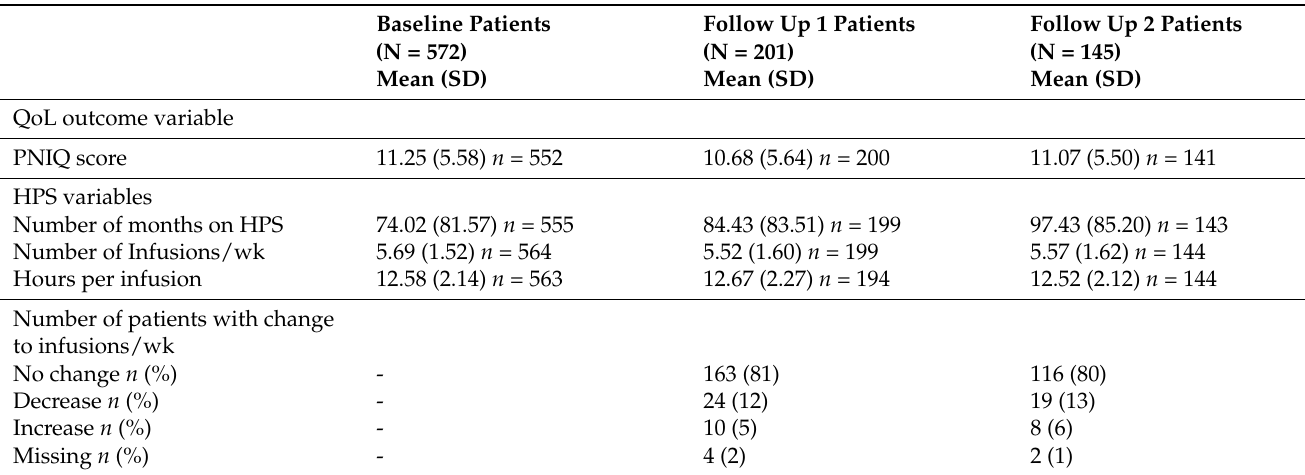
Table 2. Parenteral Nutrition Impact Questionnaire scores and home parenteral support use at baseline, follow up 1, and follow up